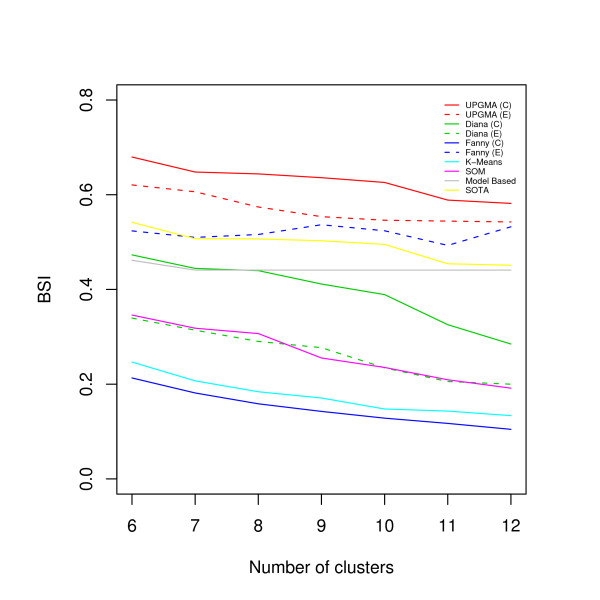
BSI for various clustering algorithms applied to the positively expressed genes in yeast sporulation data with functional classes from FunCat.